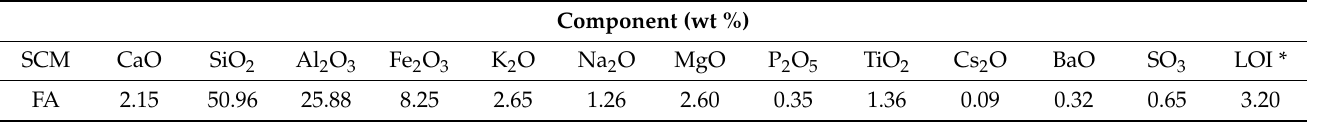
Table 1. Chemical composition of fly ash used.